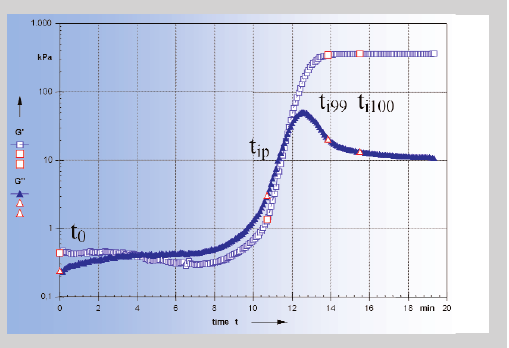
Figure 8 (left): Transition from the supersaturated suspension to the immobilized condition. Figure 9 (right): Immobilization of a paper coating.